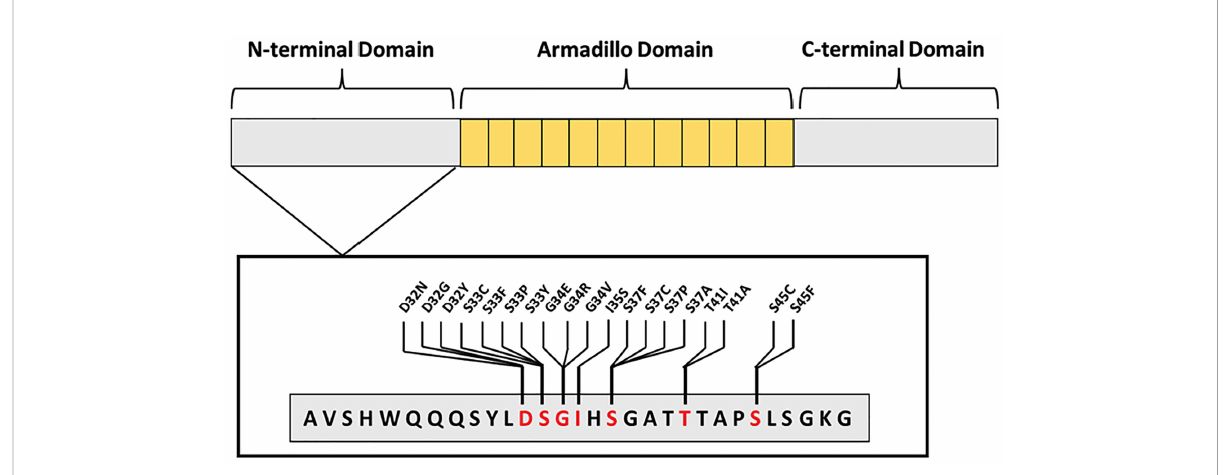
FIGURE 3 Most commonly mutated b -catenin amino acid residues occurring in endometrial cancer. All mutations occur in exon 3, found within the N- terminus, blocking GSK3 b or CK1 phosphorylation sites — S33, S37, T41, S45 — or adjacent residues — D32, G34, and